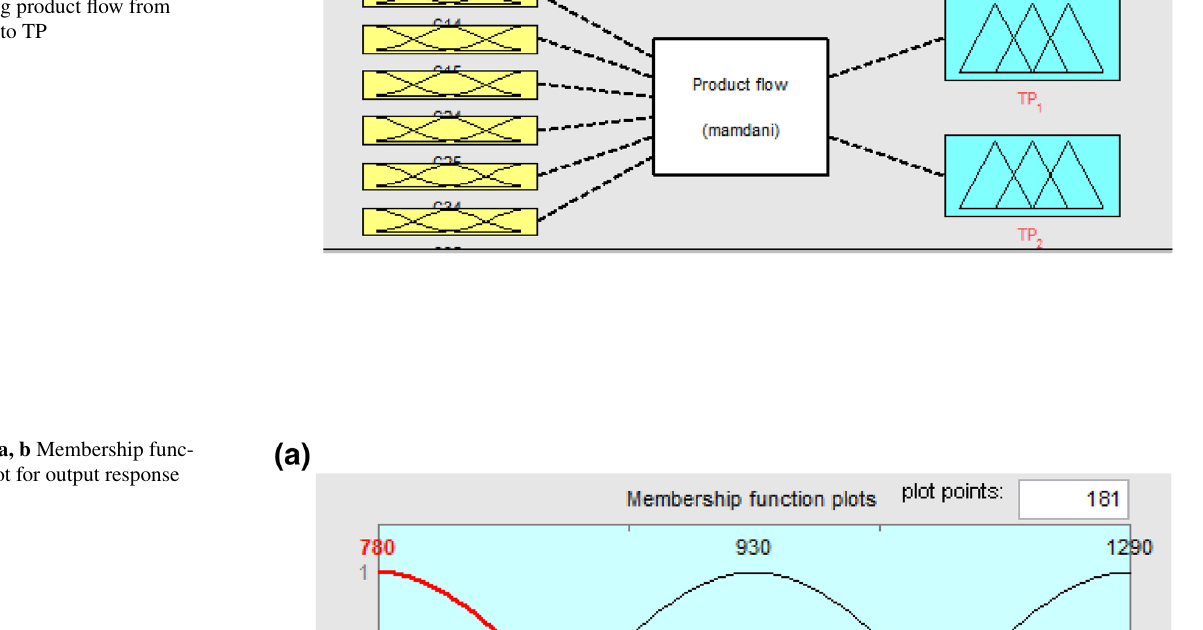
Fig. 1 Mamdani architecture showing product flow from source to TP